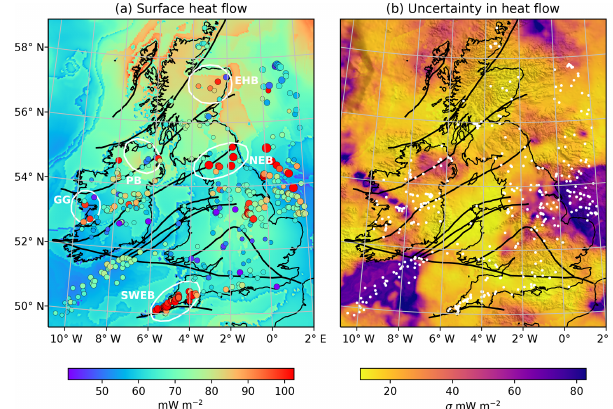
Figure 10. Surface heat flow in the British Isles and its uncertainty, (a) Surface heat flow overlain with palaeoclimate-corrected heat flow observations compiled from Mather et al. (2018) in Ireland and Pollack et al. (1993) elsewhere – larger circles indicate a higher misfit compared to the simulated heat flow; (b) uncertainty of heat flow determined from an ensemble of model simulations with vari- able Curie depth, overlain with the locations of heat flow data in white. Circled regions include GG as Galway granite, PB as Palaeo- gene basalt, SWEB as southwest England batholith, NEB as north- ern England batholith, and EHB as eastern highlands